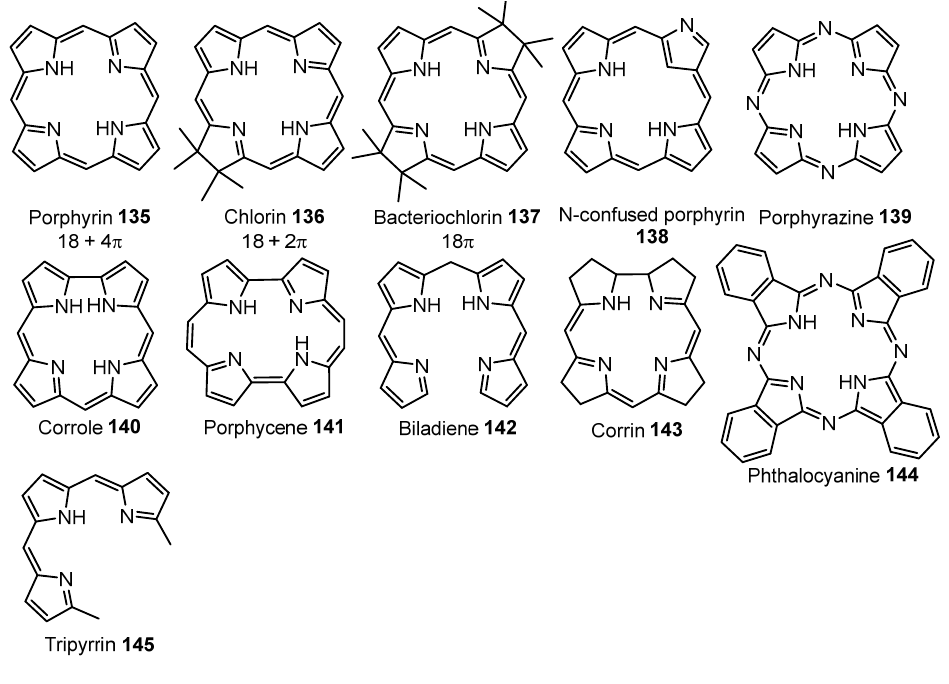
Figure 39. Basic structures of porphyrins and related derivatives.